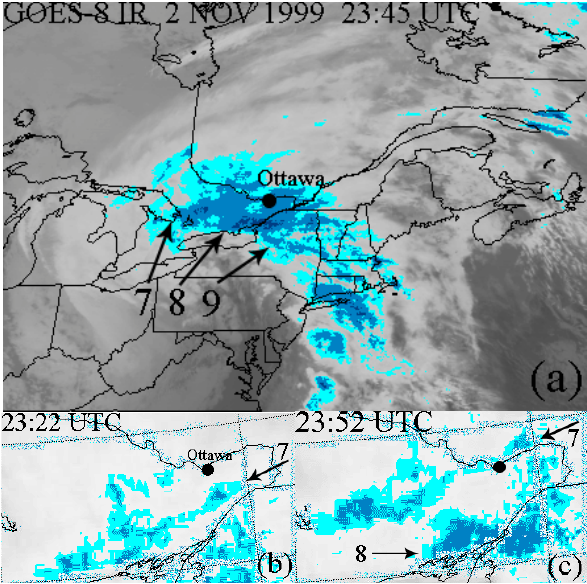
Fig. 7. GOES-8 infrared images showing cloud bands (numbers refer to RSBT enhancements in Fig. 6a) in a mid-latitude cyclone. Dark-blue coding is used to bring out low-contrast features and to highlight low cloud-top temperatures of convective cloud bands. Fig. 6. The cross-correlation and spectral analysis of the ground magnetic field, TIDs and cloud/rain bands. ( a ) Time series of (top) UPN X-component and (middle) averaged radar ground scatter power (TIDs) at two ranges are shifted with respect to the radiometer data (bottom). The arrows are the same as in Fig. 2. The correspondence between TIDs/PIFs and the RSBT enhancements is suggested. ( b ) Normalized FFT spectra of detrended time series. ( c-d ) Cross- correlation analysis of pairs of time series excluding the last 90 min interval (hatched).